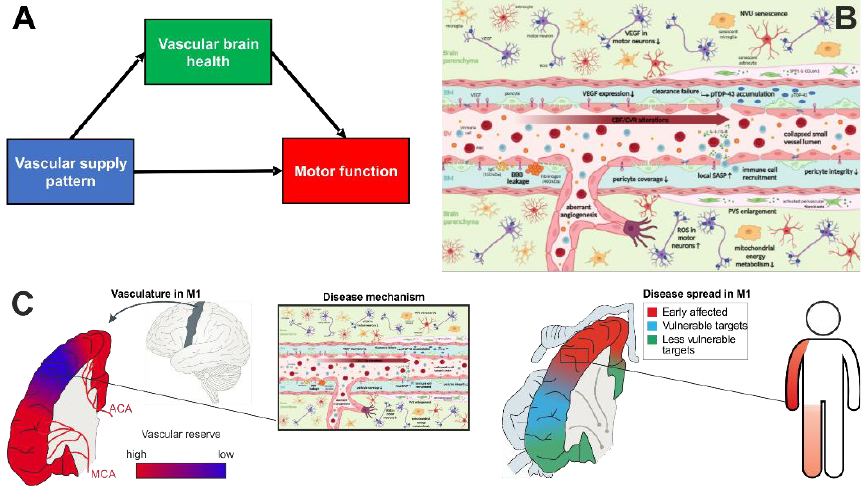
Figure 2. Motor cortical supply affects motor function and disease spread through microvascular brain health. ( A ) Overview of the proposed mediation model in ALS, with motor cortical supply as the independent, microvascular brain health as the mediation and motor function as the outcome variable. In ( C ), each of the variables presented in ( A ) are outlined in detail. ( C left) Areas of lower vascular supply (in blue), putatively marked by larger distances to feeding arteries, are characterized by lower local vascular resistance and resilience, which is mediated by a cascade of microvascular alterations ( C center, enlarged in B ). ( C right) Degree of motor cortical resistance and resilience determines the time course of the affection of different motor cortical areas. For example, low supply of the ipsilateral motor cortical hand area (e.g., caused by MCA single supply), promotes symptom onset in the contralateral upper limb (in red). Motor cortical regions at risk, i.e., characterized by insufficient perfusion, e.g., due to low overlap of MCA and ACA perfusion territories and subsequently affected during cortical disease spread, determine clinical disease spread to the second body part (e.g., contralateral lower limb, in light red). ( B and C center) demonstrate motor cortical microvascular alterations: (i) reduced VEGF expression, (ii) BBB leaks, (iii) reduced small vessel pericyte coverage accompanied by CBF/CVR decrease and aberrant angiogenesis, (iv) activated fibroblasts found in enlarged PVS secreting SPP1 and COL6A1. Increased turnover of resident immune cells leads to decline of brain energy metabolism, NVU senescence with SASP, immune cell recruitment, finally advancing neuroinflammation and neurodegeneration. ACA, anterior cerebral artery; ALS, amyotrophic lateral sclerosis; BBB, blood – brain barrier; BM, basement membrane; CBF, cerebral blood flow; CNS, central nervous system; COL6A1, collagen VI alpha1; CVR, cerebrovascular reserve; EC, endothelial cell; IgG, immunoglobulin G; IL, interleukin; MCA, middle cerebral artery; MRI, magnetic resonance imaging; NVU, neurovascular unit; pTDP43, phosphorylated aggregates of 43 kDa transactive response DNA-binding protein; PVS, perivascular space; RBC, red blood cell; ROS, reactive oxygen species; SASP, senescence-associated secretory phenotype; SPP1, secreted phosphoprotein 1; VEGF, vascular endothelial growth factor.